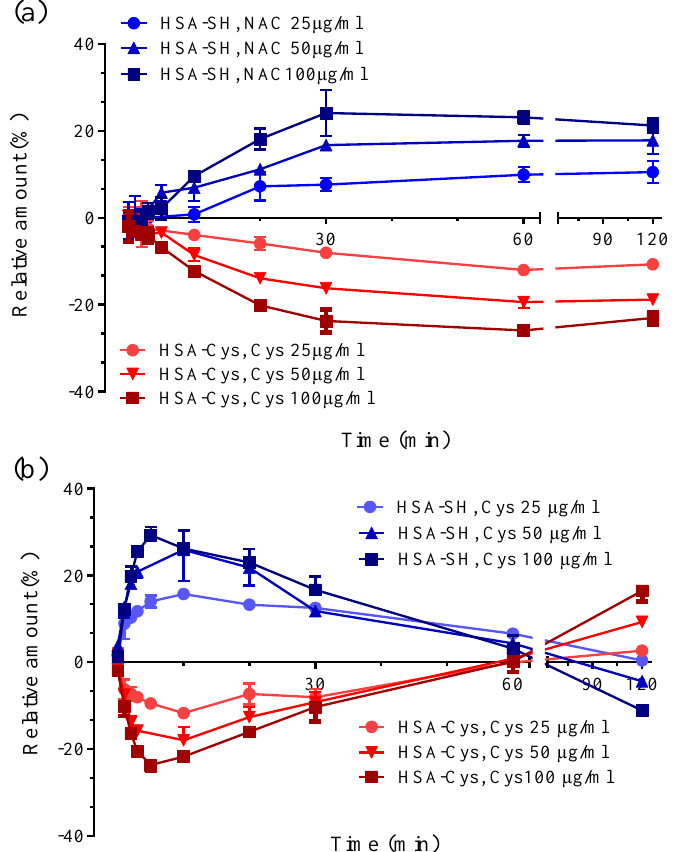
Figure 2. HSA-Cys breaking activity of NAC and Cys: Time- and dose-dependent effect of NAC ( a ) and Cys ( b ) in restoring mercaptoalbumin (upper part of the graph) by reducing the content of the cysteinylated form (lower part of the graph). Legends to the symbol are reported in the figure.